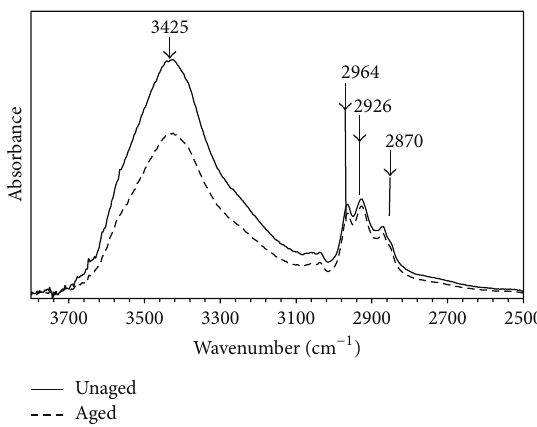
Figure 8: FTIR spectra of EHG250-68-37 composite sample in the hydroxyl and CH stretching regions (initially and after 800 h thermooxidative